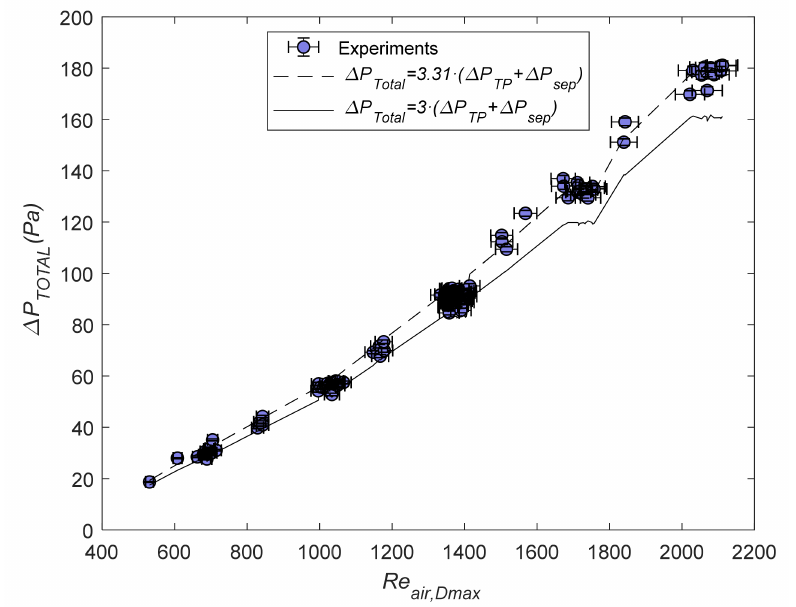
Figure 9. Total pressure drop at the air/water section of the cooling tower an predictions obtained by Equation